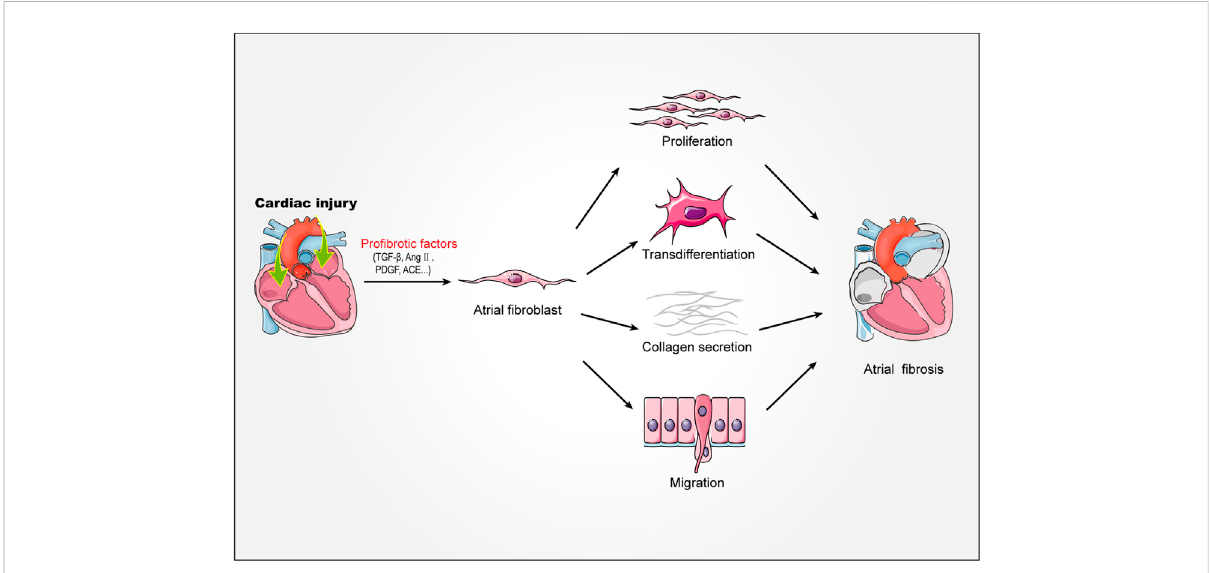
FIGURE 1 Mechanism of atrial fi brosis. Stimulated by injury factors TGF- β , Ang Ⅱ , PDGF, ACE, etc. Atrial fi broblasts proliferate, migrate, transdifferentiate, secrete collagen fi bers, and ultimately promote the formation of atrial fi brosis. TGF- β , transforming growth factor- β ; Ang Ⅱ , angiotensin II; PDGF, platelet derived growth factor; ACE, angiotensin-converting